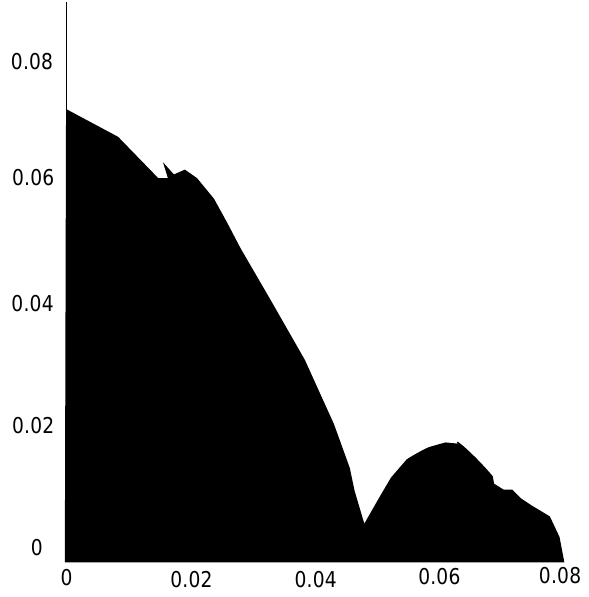
FIG. 4. Stability domain after the single-resonance